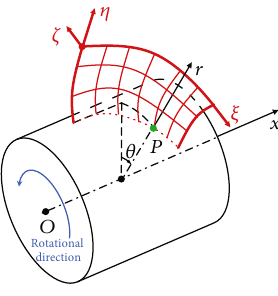
Figure 1: Coordinate